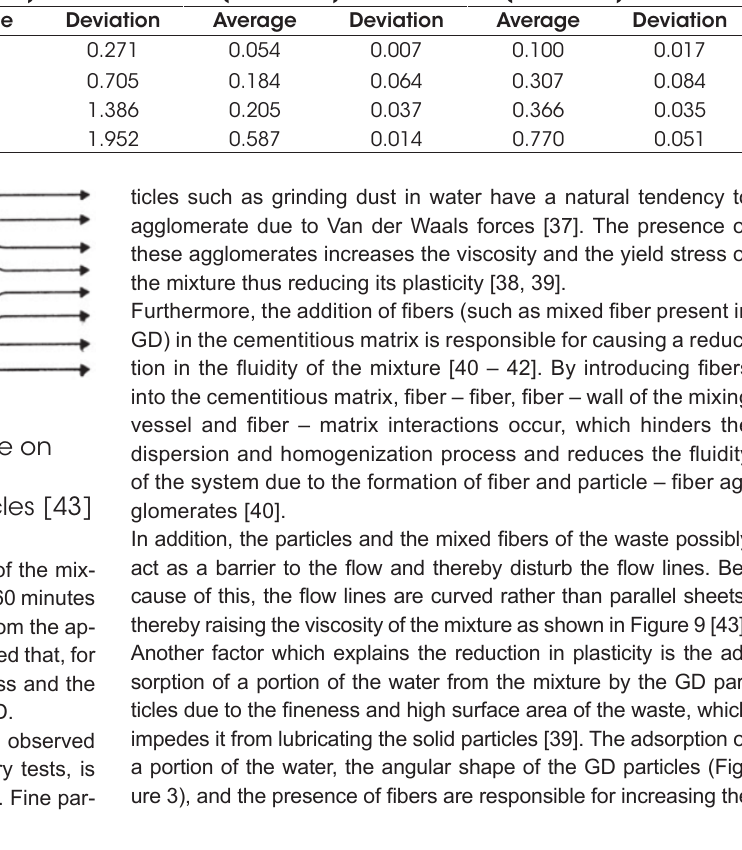
Yield stress and viscosity of the pastes with varying contents of grinding dust (GD) Paste